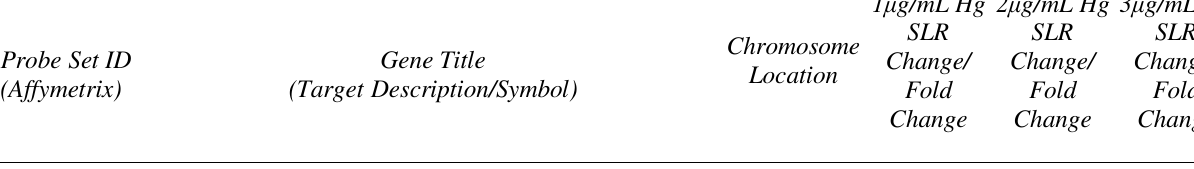
Table 1 contd.: Sample genes affected by mercury.